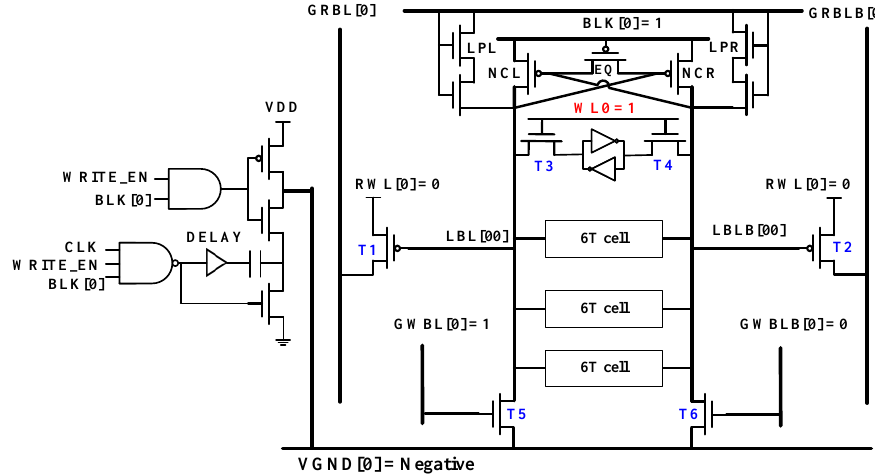
Figure 2. Proposed design of local bit-line 6 T SRAM Architecture.